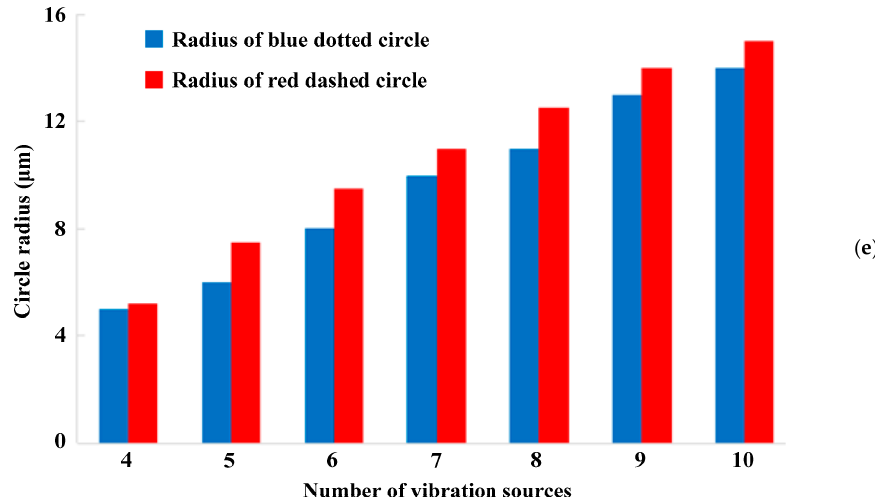
Figure 2. (Color online). Acoustofluidic field and particle trajectory excited by single-layer vibration sources with the same initial phase. ( a ) Patterns of sound pressure field. ( b ) Patterns of acoustic streaming field. ( c ) Patterns of microparticle trajectory. ( d ) Averaged acoustic streaming velocity magnitude vs. radius of red dashed circle. ( e ) Different circle radii vs. number of vibration sources.